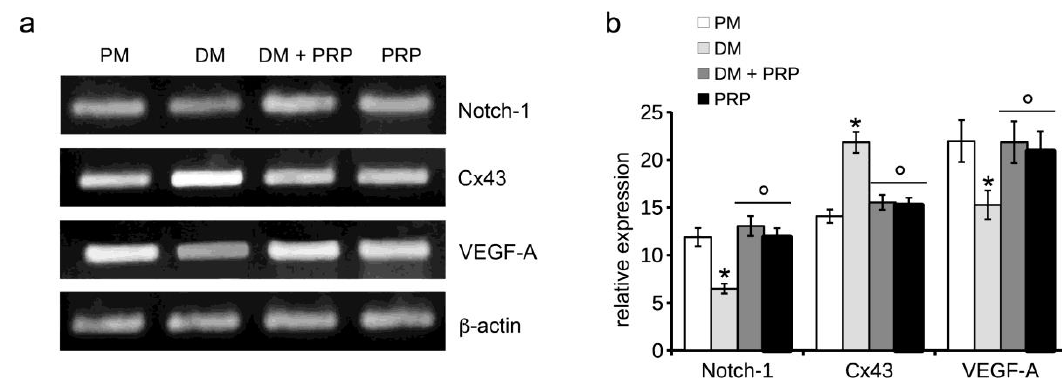
Figure 3. RT-PCR analysis of Notch-1, Connexin 43 (Cx43), and VEGF-A expression. NIH/3T3 fibroblastic cells were cultured in differentiation medium (DM, low serum medium plus 2 ng/mL TGF- β 1) in the absence or presence of 1:50 diluted PRP (DM + PRP) or in the presence of 1:50 serum-free medium diluted PRP (PRP). Cells cultured in proliferation medium (PM) served as controls, undifferentiated cells. ( a ) Representative agarose gels. ( b ) Histogram showing the densitometric analyses of the bands normalized to β -actin. Data shown are mean ± S.E.M. and represent the results of at least three independent experiments performed in triplicate. Significance of difference: * p < 0.05 vs. PM; ° p < 0.05 vs. DM.